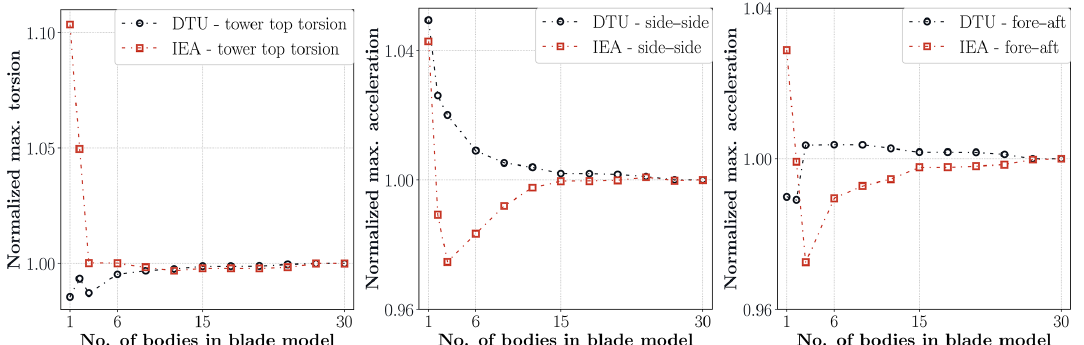
Figure 10. Normalized tower-top maximum torsion moments, side–side and fore–aft accelerations. Values are normalized with respect to the results of the 30-sub-body